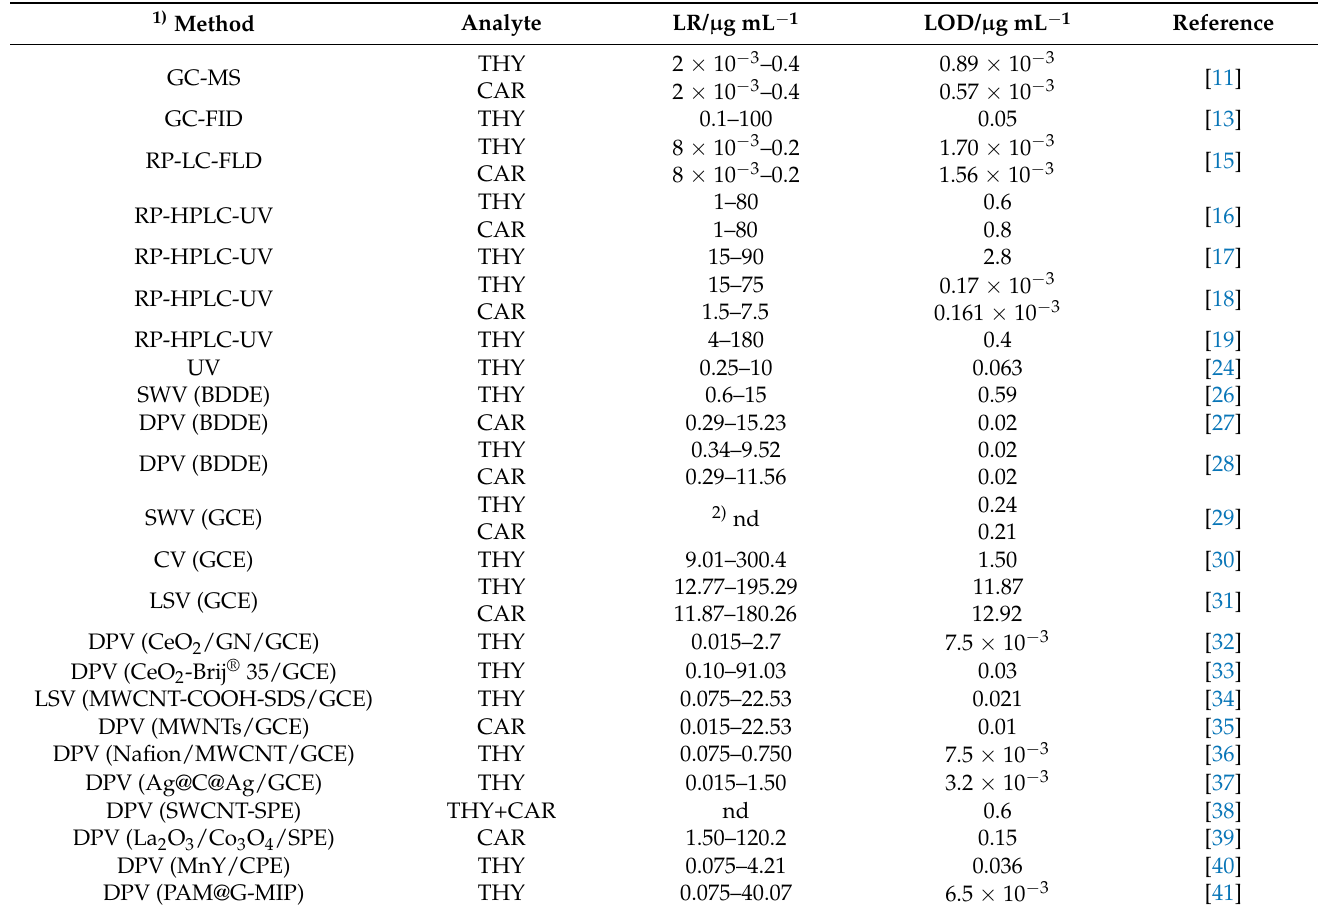
Table 1. Comparison of the main analytical parameters characteristic of methods of thymol and carvacrol